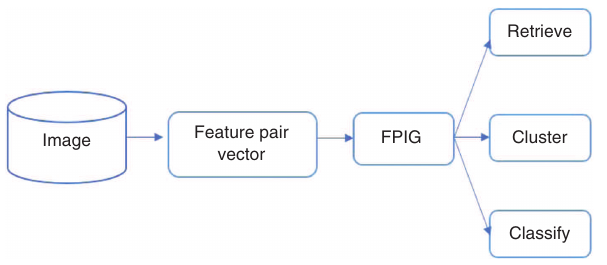
Figure 2: The Overall Framework of the Proposed